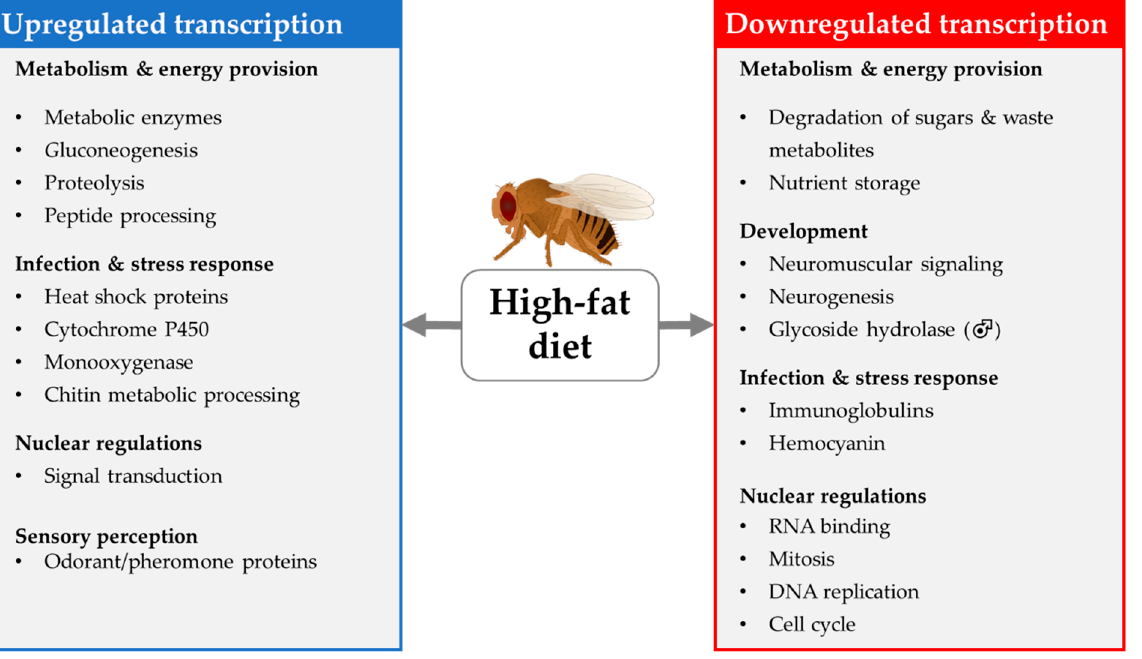
Figure 13. Transcriptional changes in Drosophila melanogaster resulting from high-fat diet (HFD) feeding. An HFD induces upregulation (blue box) and downregulation (red box) of genes involved in metabolism and energy provision, infection and stress responses, nuclear regulation, sensory perception, and development (modified from [152,156,157,159,162]).